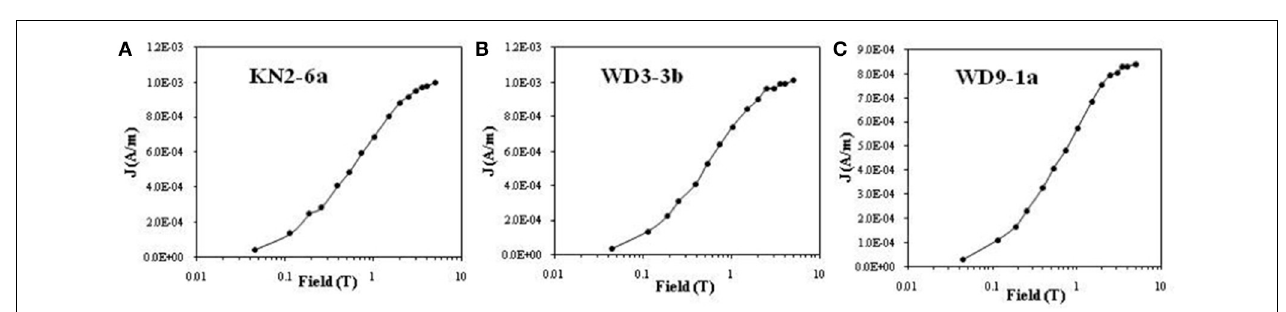
FIGURE 5 | IRM acquisition of Moenave Formation samples. All three samples ( A , Northern Kanab; B,C , Washington Dome) have nearly reached saturation by 5 T.